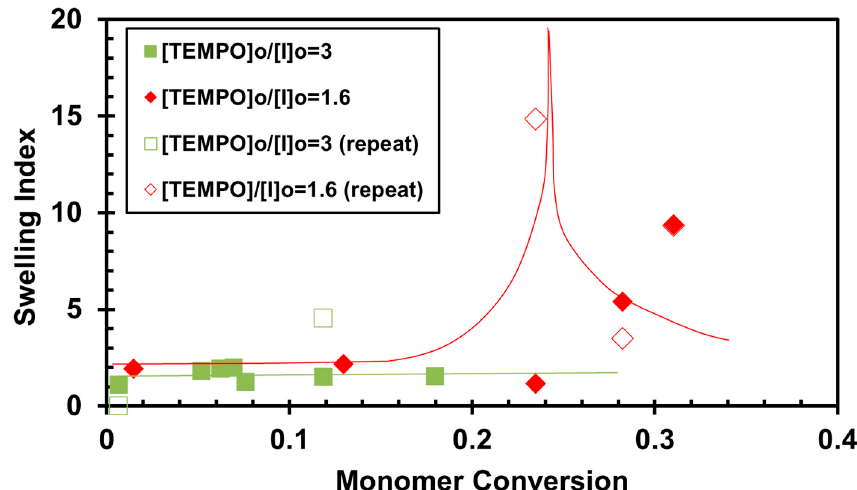
Figure 12. Effect of controller (TEMPO) content on the evolution of the SI versus conversion for the NMC of STY/DVB in scCO2 at [DVB] = 1 wt.%, T = 120 ◦ C, and P = 207 bar. Open symbols are replicates of the